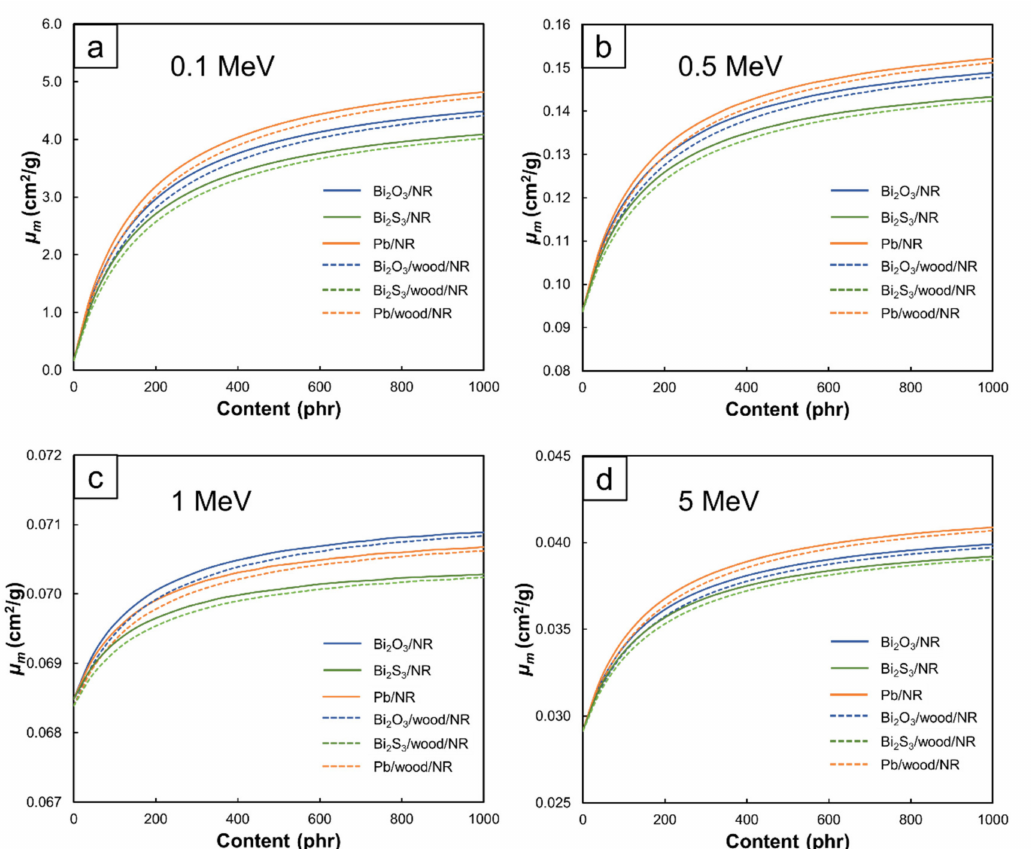
Figure 4. µ m values of Bi 2 O 3 /NR, Bi 2 O 3 /wood/NR, Bi 2 S 3 /NR, Bi 2 S 3 /wood/NR, Pb/NR, and Pb/wood/NR composites with filler contents varied from 0–1000 phr, determined at photon energies of ( a ) 0.1 MeV, ( b ) 0.5 MeV, ( c ) 1 MeV, and ( d ) 5 MeV using XCOM.